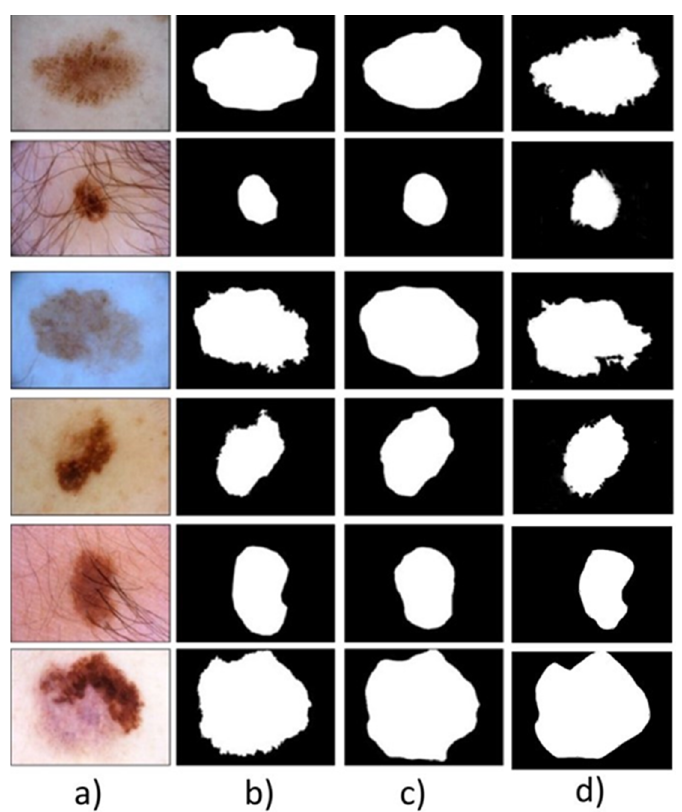
Figure 10. The visual images taken from ISIC 2018 image database model (present without the black frame). ( a ) The original image, ( b ) the given binary mark (ground truth), ( c ) the prediction effects of the method (Att U-Net + GN). ( d ) The results of our RL algorithm. As can be seen, our segmentation masks corners are sharp and clear.